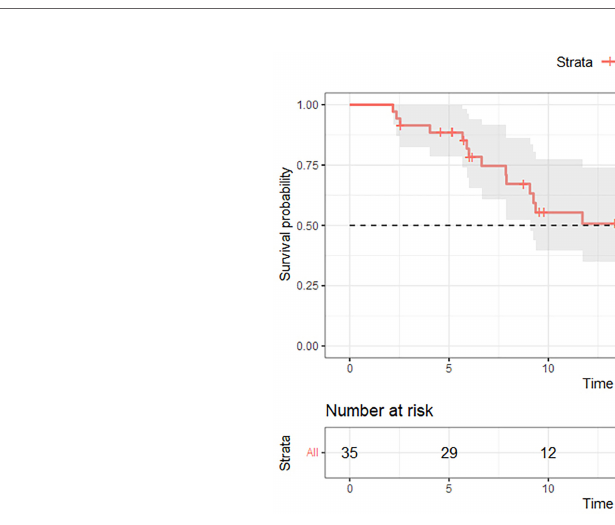
FIGURE 3 | Overall survival of patients treated with fruquintinib plus pd-1 inhibitor.